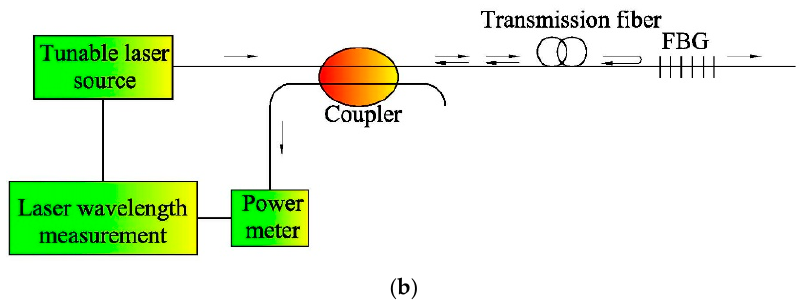
Figure 2. Typical FBG interrogation configurations [12]. ( a ) FBG measurement with a broadband source and an OSA; ( b ) FBG measurement with tunable laser and reflected power detection.